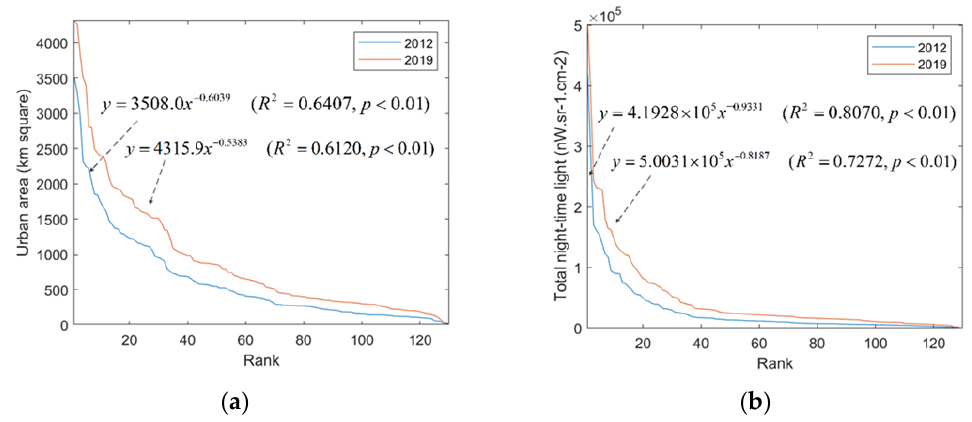
Figure 7. Rank-size curve of 130 cities in YREB: ( a ) Urban area; ( b ) Total night-time light.